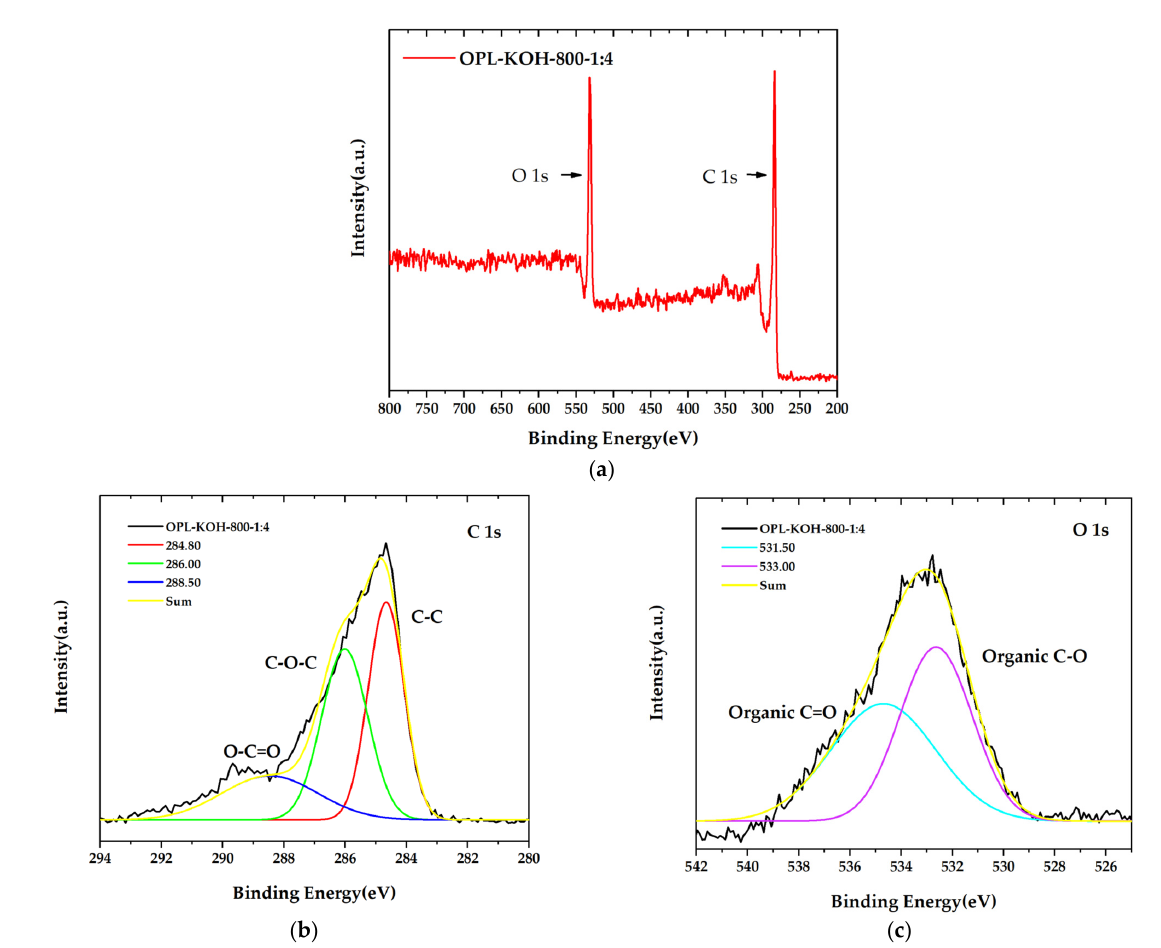
Figure 7. X-ray photoelectron spectroscopy (XPS) spectra of OPL − KOH − 800 − 1:4 ( a ) the main XPS spectra, ( b ) C1s spectra peak, and ( c ) O1s spectra.